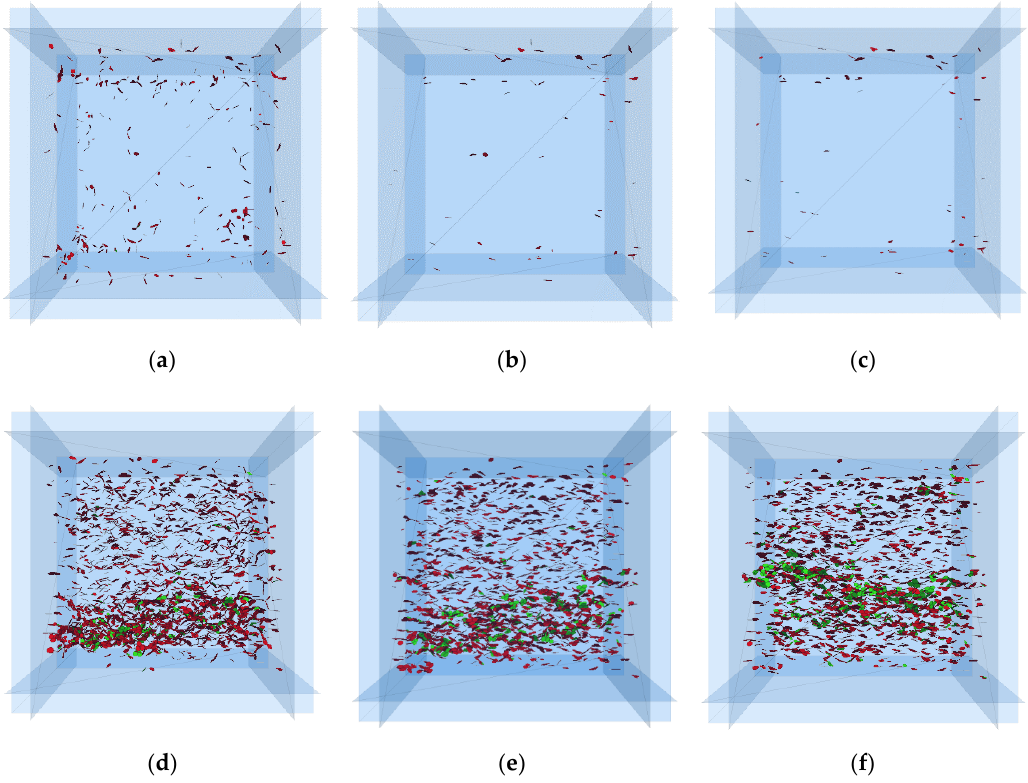
Figure 15. Comparison of crack formation in the numerical sample for stress path ODEC (Figure 8): ( a – c ) after the relaxation of σ 3 (point E, Figure 8) and ( d – f ) at peak strength (point C, Figure 8) for σ 2 = 0, σ 2 = σ 1 /2 = 45 MPa, and σ 2 = σ 1 = 90MPa. Red = tensile crack, green = shear crack. ( a ) σ 1 = 90 MPa; σ 2 = 0 (964 cracks); ( b ) σ 1 = 90 MPa; σ 2 = 45 MPa (323 cracks); ( c ) σ 1 = σ 2 = 90 MPa (204 cracks); ( d ) σ 1 = 90 MPa; σ 2 = 0; ( e ) σ 1 = 90 MPa; σ 2 = 45 MPa; ( f ) σ 1 = σ 2 = 90 MPa.